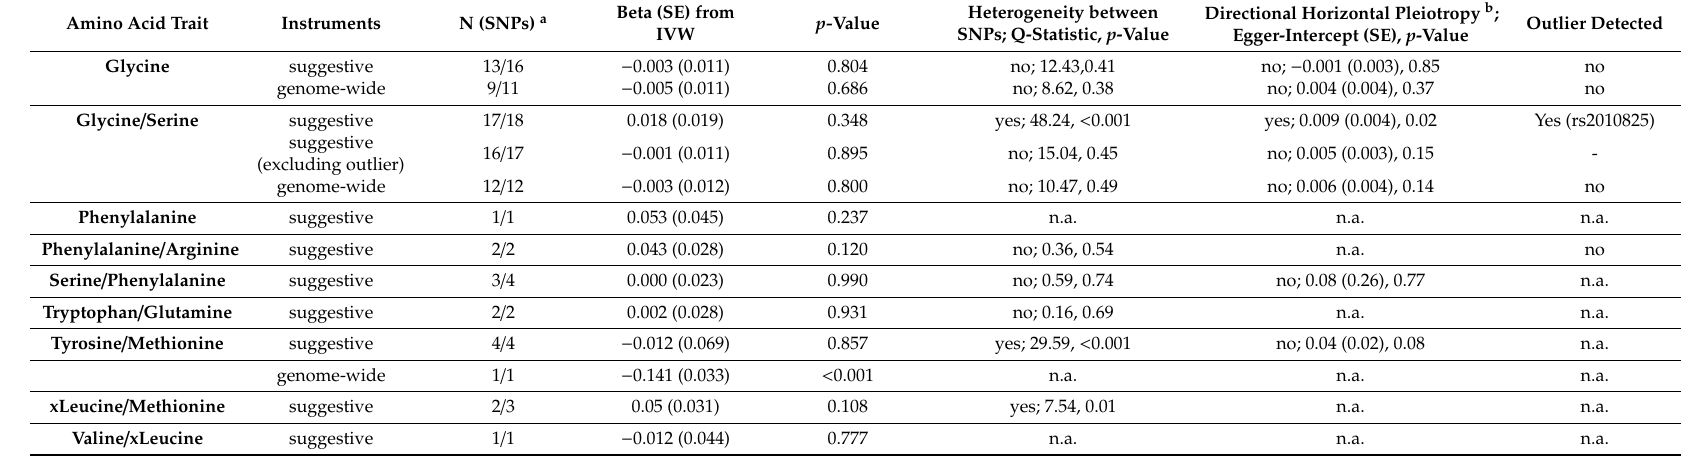
Table 3. Total causal e ff ects of amino acid traits and of type 2 diabetes using instruments with R 2 < 0.3.